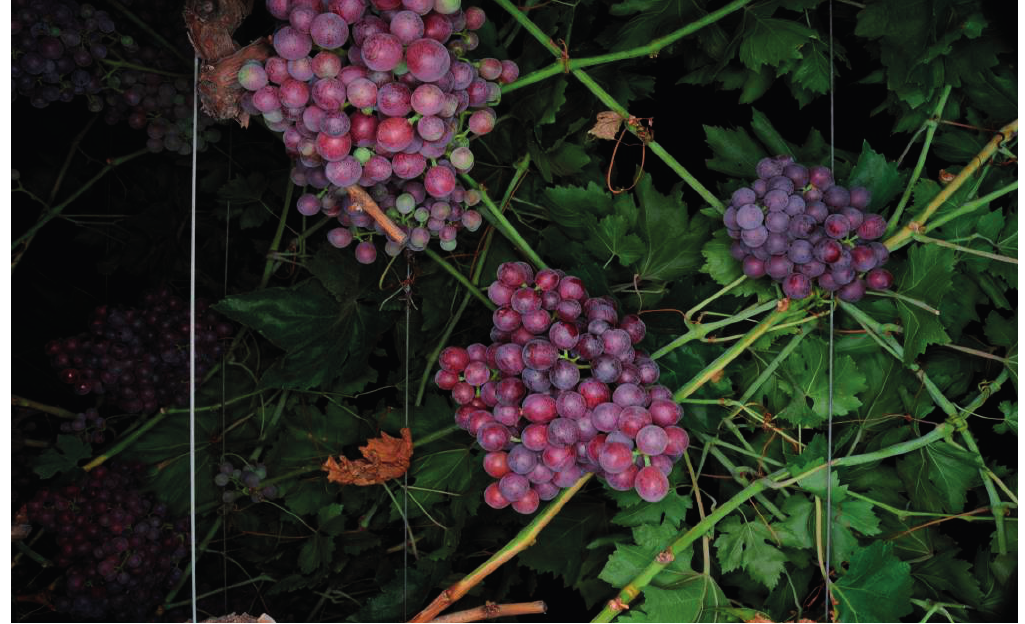
Figure 1. Example vineyard image: 4288 × 2844